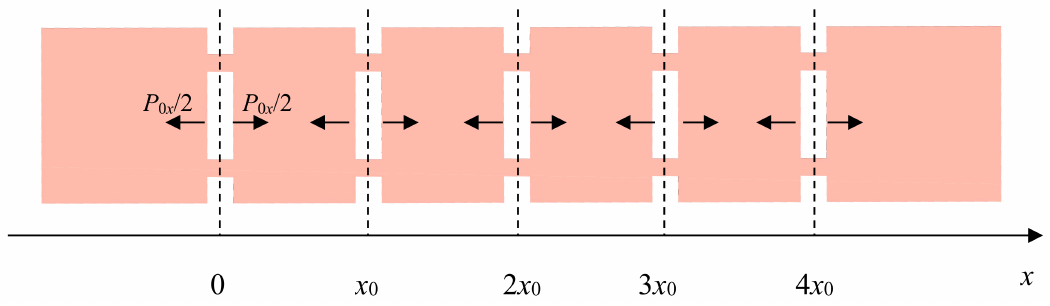
Figure 2. Fuselink structure with additional power